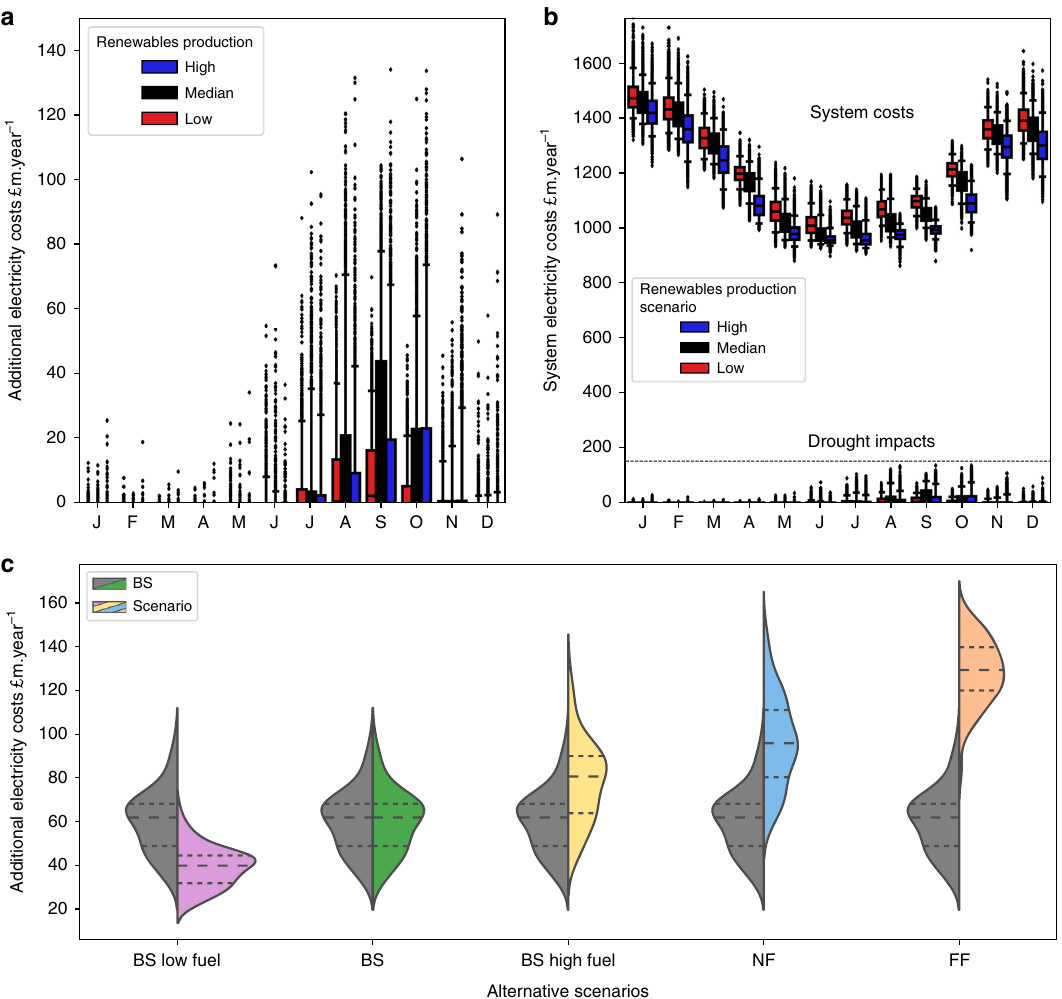
Fig. 6 Sensitivity of results to monthly variation in renewables production and long-term fuel price changes. a Sensitivity of additional electricity costs during months with low (10th percentile), median and high (90th percentile) non-thermal renewables production. b Overall, these additional costs may be relatively small compared with the system costs and seasonal fl uctuation. c Distribution of costs in alternative scenarios (right halves) compared to Baseline climate: low and high fuel costs; and near future (NF) and far future (FF) climate impacts; compared with the baseline (BS in grey/green). Boxplot notch is the median, the bar is the inter-quartile range (IQR), whiskers extend to 5th and 95th percentiles, dots are outside this range ( a , b ). Dashed lines show the median and inter-quartile ranges ( c